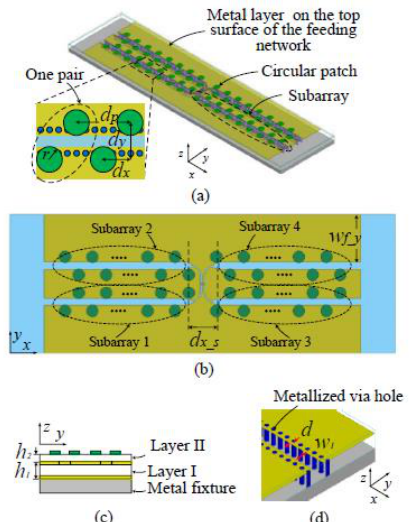
Figure 1: 3D-view, top view and side view of IDW fed patch